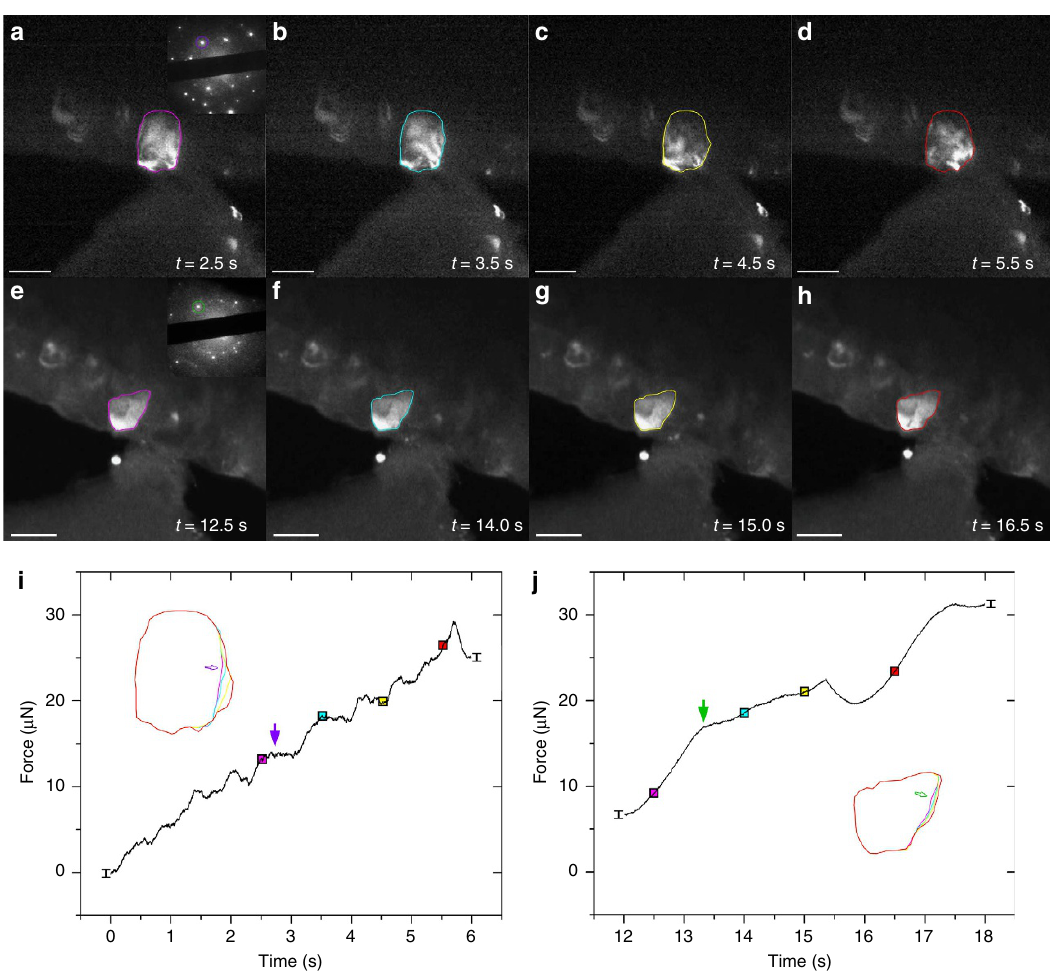
Figure 3 | In situ TEM indentation tests of NC Al films showing mechanically driven GB migration. ( a – d ) Time-series of snapshots recorded during test of the film with C O of 0.7at.%. Inset: selected-area diffraction pattern of the film, with the outlined Al(111) spot used for dark-field TEM imaging. Scale bars, 100nm. ( i ) Force–time curve. Vertical error bars show the peak-to-peak noise ( B 1 m N) in force. Solid squares correspond to the snapshots shown in a – d . Solid arrow shows the onset of stress-driven GB migration. Inset: shape evolution of the grain outlined in a – d . GB migration only occurs in regions near the indenter. Open arrow shows the ‘hotspot’ where GB migration was initiated. ( e – h , j ) Corresponding results of the film with C O of 2.1at.%. GB migration is still observed albeit to a lesser extent and initiated at higher forces. Scale bars,